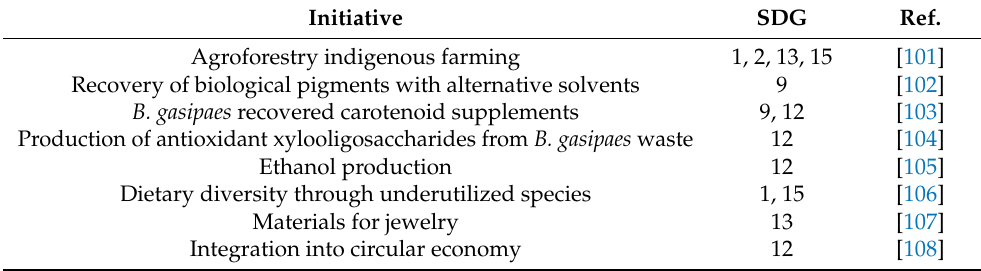
Table 9. Sustainable Development Goals (SDG) initiatives including B. gasipaes . Initiative